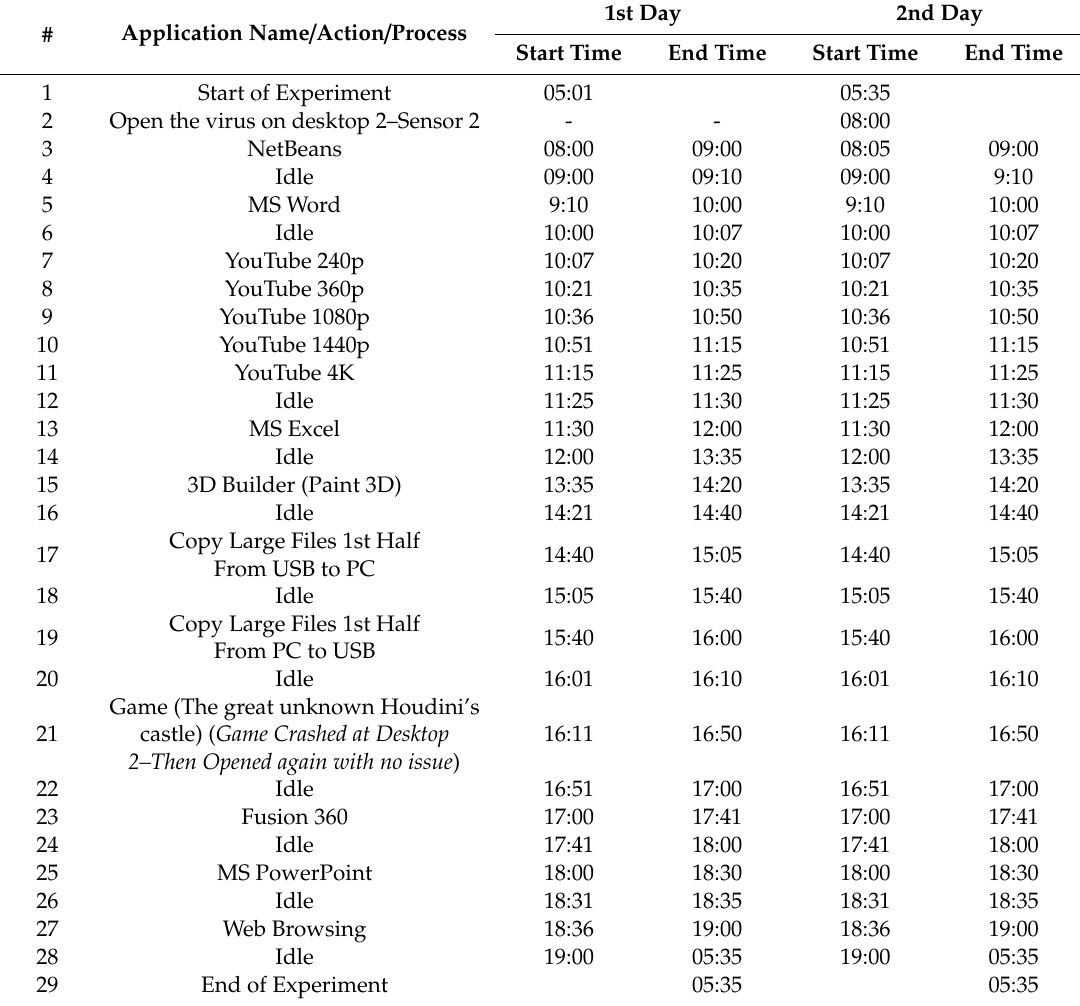
Table 1. Application execution